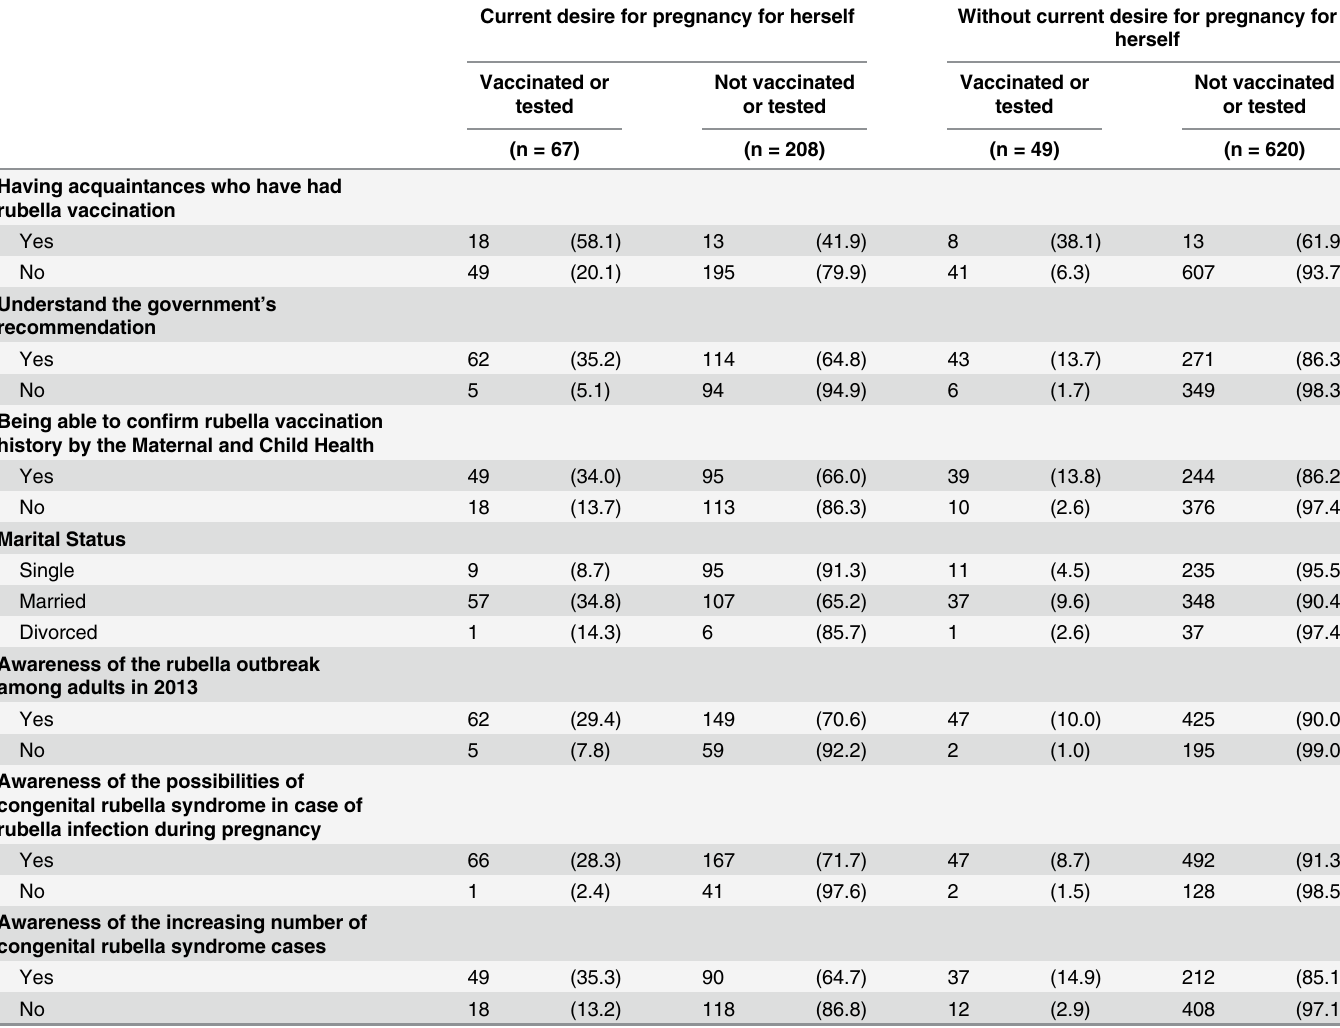
Table 5. Vaccination or antibody testing for rubella in 2013 for women.